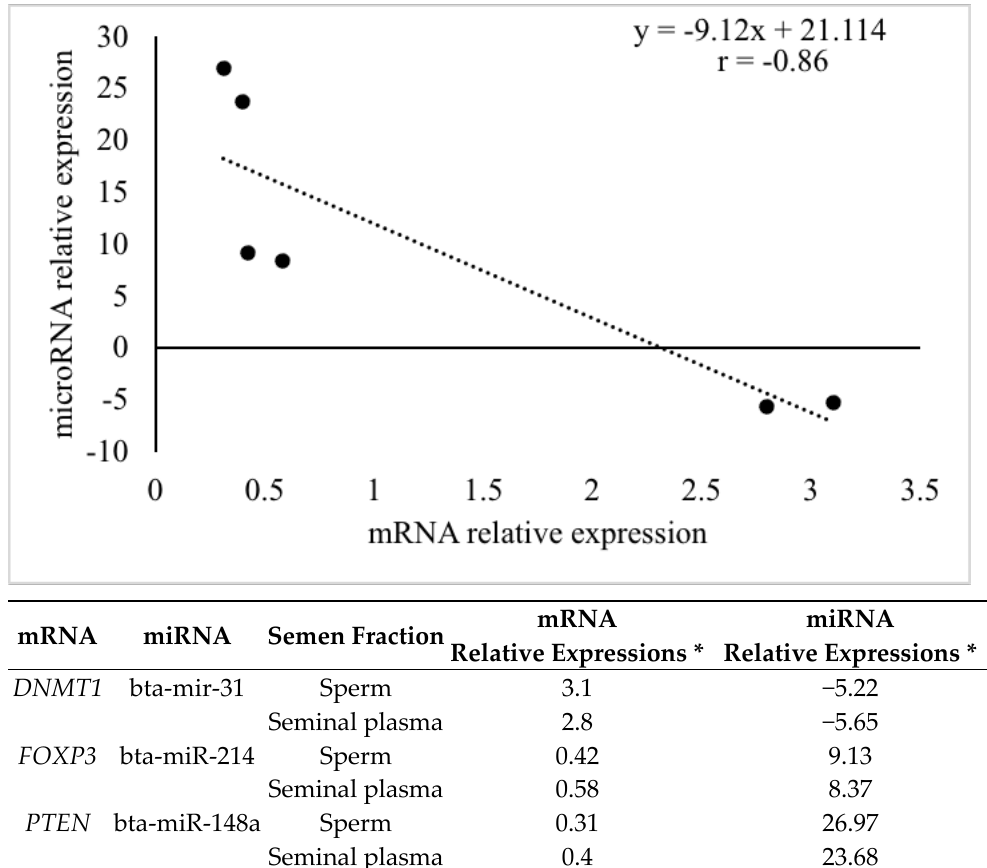
fertile bulls ( p < 0.05). Figure 8. Correlation coefficient ( r ) of mean relative expressions of miRNA and mRNA pairs. Pearson correlation coefficient p < 0.05.